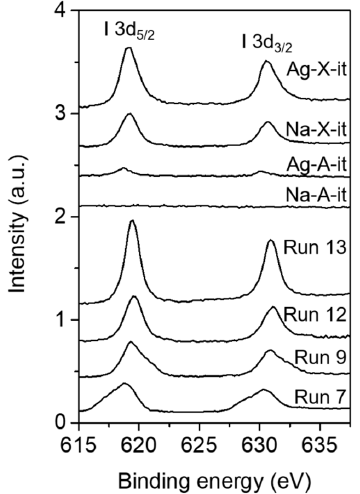
Figure 5. I 3d XPS spectra of the representative products synthesized by the interzeolite transformation of Na-A and Na-X, and the interzeolite transformation products of CH 3 I adsorbed Na-A, Ag-A, Na-X, and Ag-X.